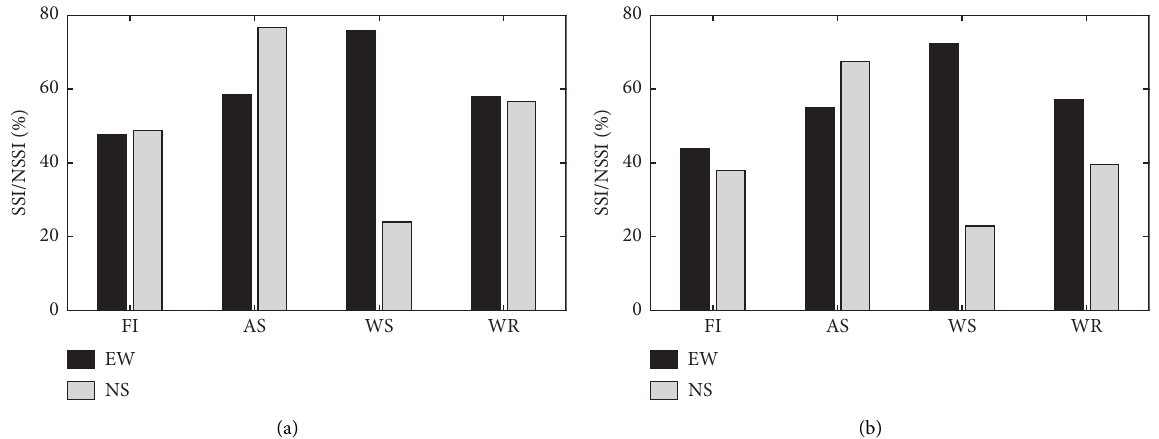
Figure 8: Results of RMS ratios (SSI/NSSI) of acceleration and base shear time history data with different soil conditions. (a) RMS ratio of the acceleration time history at the top of the 1 st floor. (b) RMS ratio of the base shear time history.